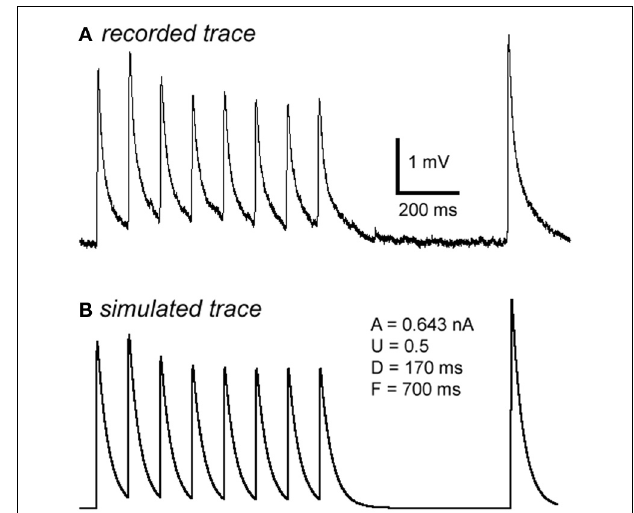
FIGURE A1 | Western blot monitoring of A β stock solutions. Monomer predominant preps as shown in lane 1 were used for the recording of single synaptic connections. Synthetic A β peptides were solubilized in 1,1,1,3,3,3-hexafluoro-2-propanol(HFIP), aliquoted, dried and stored at − 80 ◦ C. A working stock solution (0.1mM) was then prepared and stored at − 80 ◦ C for dilution immediately before use. Aged or oligomerized preps as appear in lane 5 were not used in the current work.